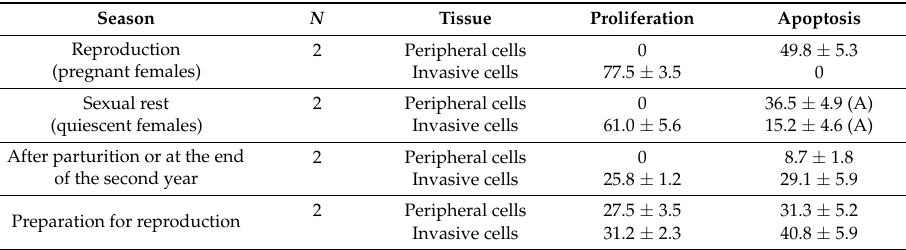
Table 4. Proliferation indexes (Ki67) and percentages apoptosis indexes (TUNEL/Apostain) in atretic follicles of Typhlonectes compressicauda during the year. (A): apoptosis detected with Apostain method. N : number of